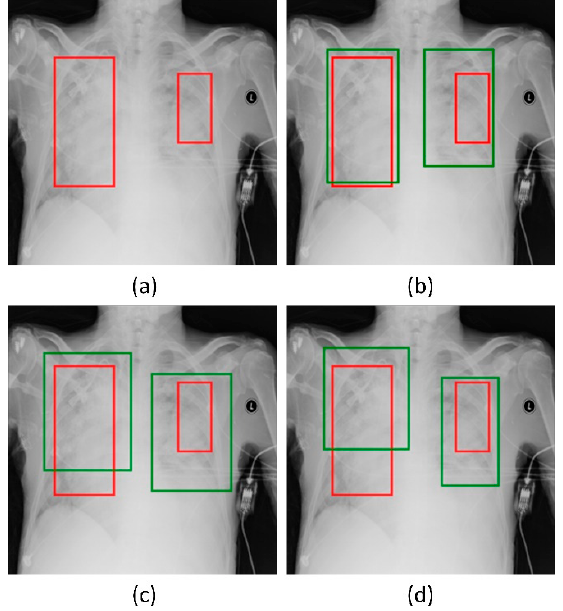
Figure 5. PR curves of the RetinaNet models initialized with varying weights for the classifier back- bones. ( a ) ResNet-50 with CXR image modality-specific weights + focal Tversky loss; ( b ) ResNet-50 with CXR image modality-specific weights + focal loss, and ( c ) ResNet-50 with random weights + focal loss.